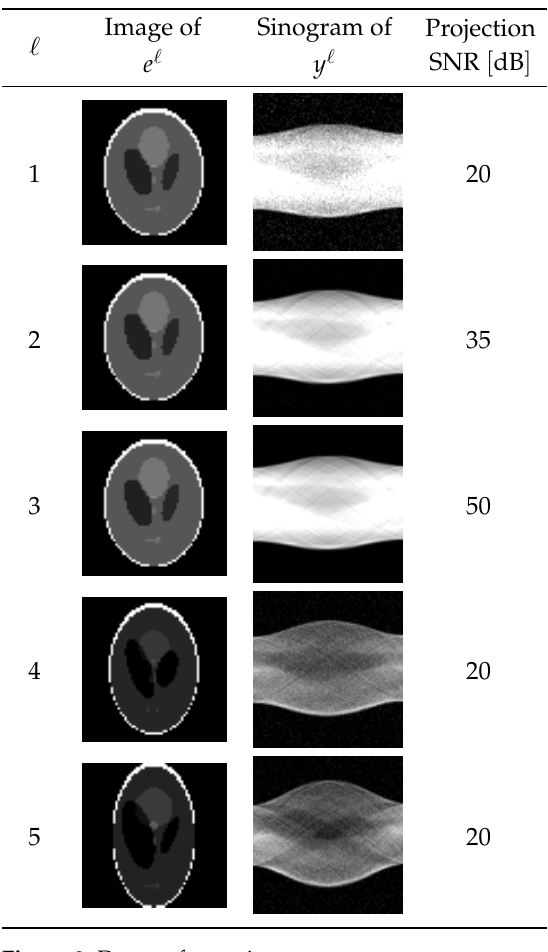
Figure 9. Dataset for